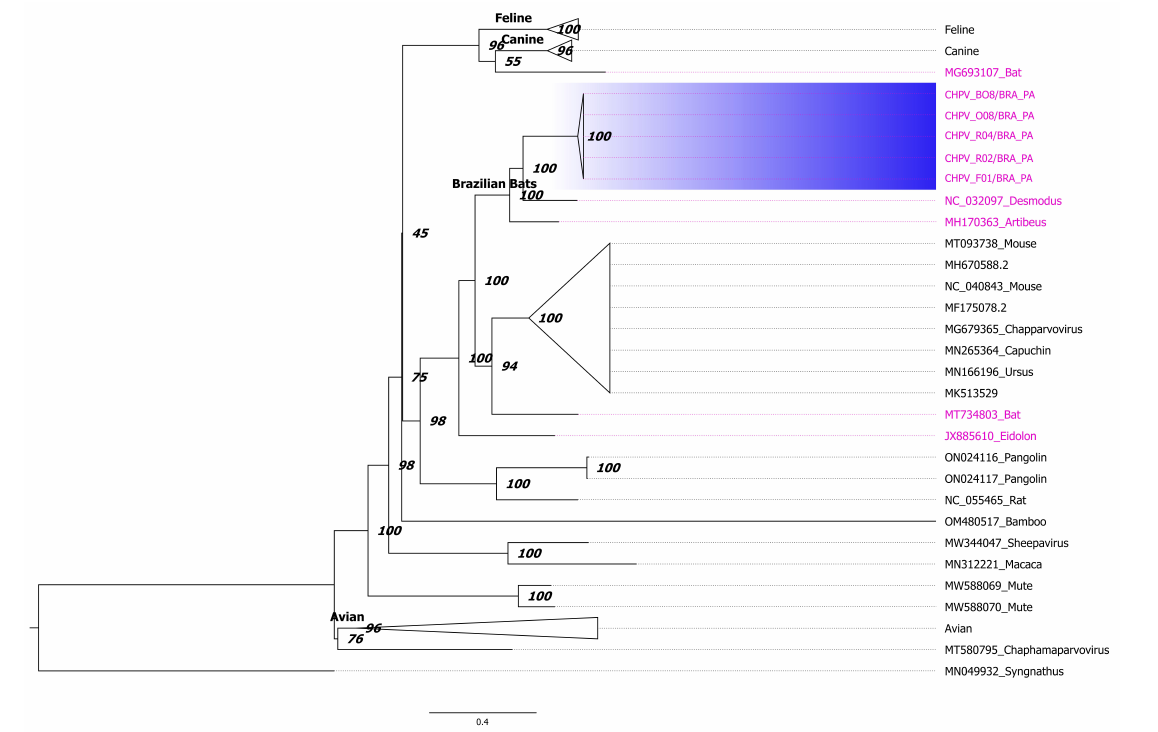
2.Figure 2. Maximum likelihood tree of chaphamaparvoviruses. The tree was constructed using Figure complete CHPV. Some clades composed by sequences isolated from the same host (i.e., Feline, Canine and Avian) were collapsed to facilitate the visualization. Sequences identified in bats are indicated by magenta color. The tree is unrooted and numbers in the nodes represent bootstrap values. Horizontal line under the tree indicates the number of nucleotide substitutions per site. The tree was constructed using GTR model plus gamma correction and the proportion of invariable sites was estimated. Bootstrap values were calculated using the ultra-fast approximation approach